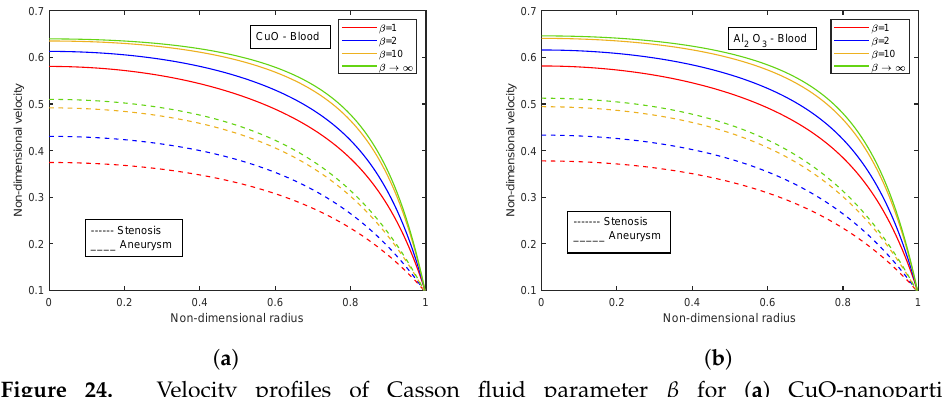
Figure 24. Velocity profiles of Casson fluid parameter β for ( a ) CuO-nanoparticles, ( b ) Al 2 O 3